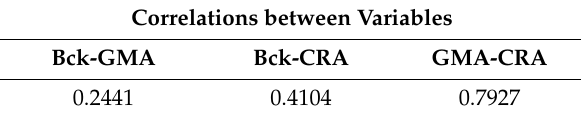
Table 1. Correlation between the three variables background (D1), GMA (Dcx) and CRA (N), using covariance (Equation 3).